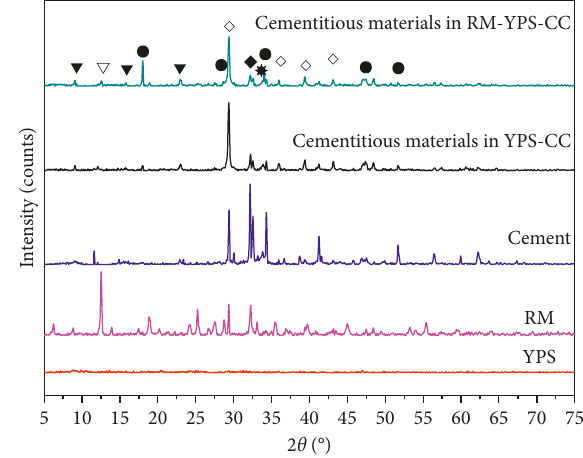
Figure 5: XRD results of the cementitious materials in concrete specimens RM-YPS-CC, YPS-CC, cement, RM, and YPS. :